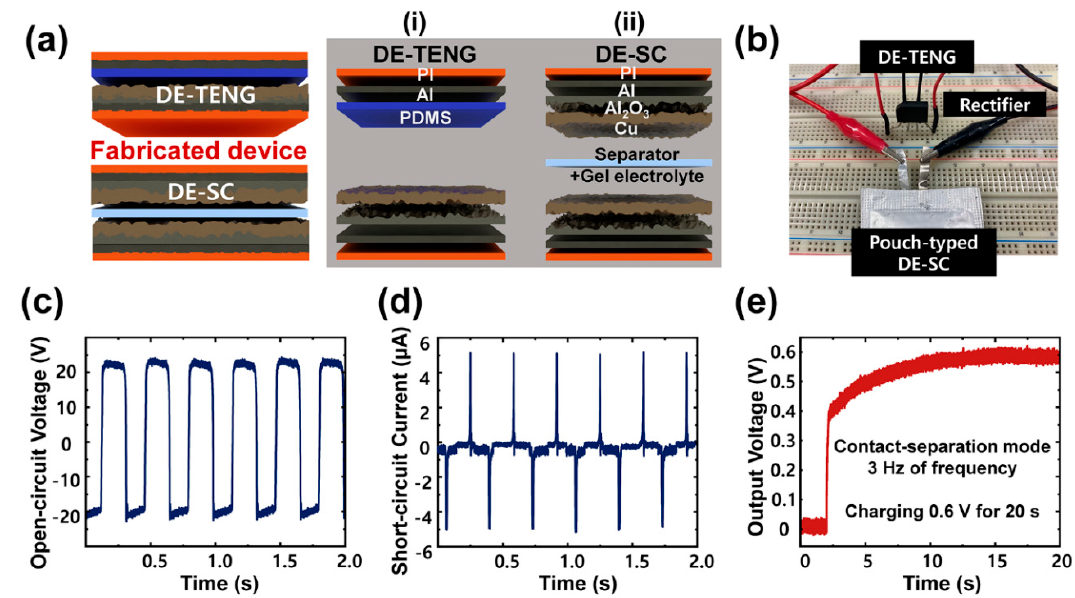
Figure 6. The device of self-powered energy conversion and storage we fabricated. ( a ) Schematic illustration of the device combining (i) the DE-TENG and (ii) the DE-SC. ( b ) Photograph of the circuit diagram with a rectifier, the DE-TENG and the DE-SC. ( c ) Open-circuit voltage and ( d ) short-circuit current of the DE-TENG. ( e ) Charging the DE-SC with the DE-TENG.